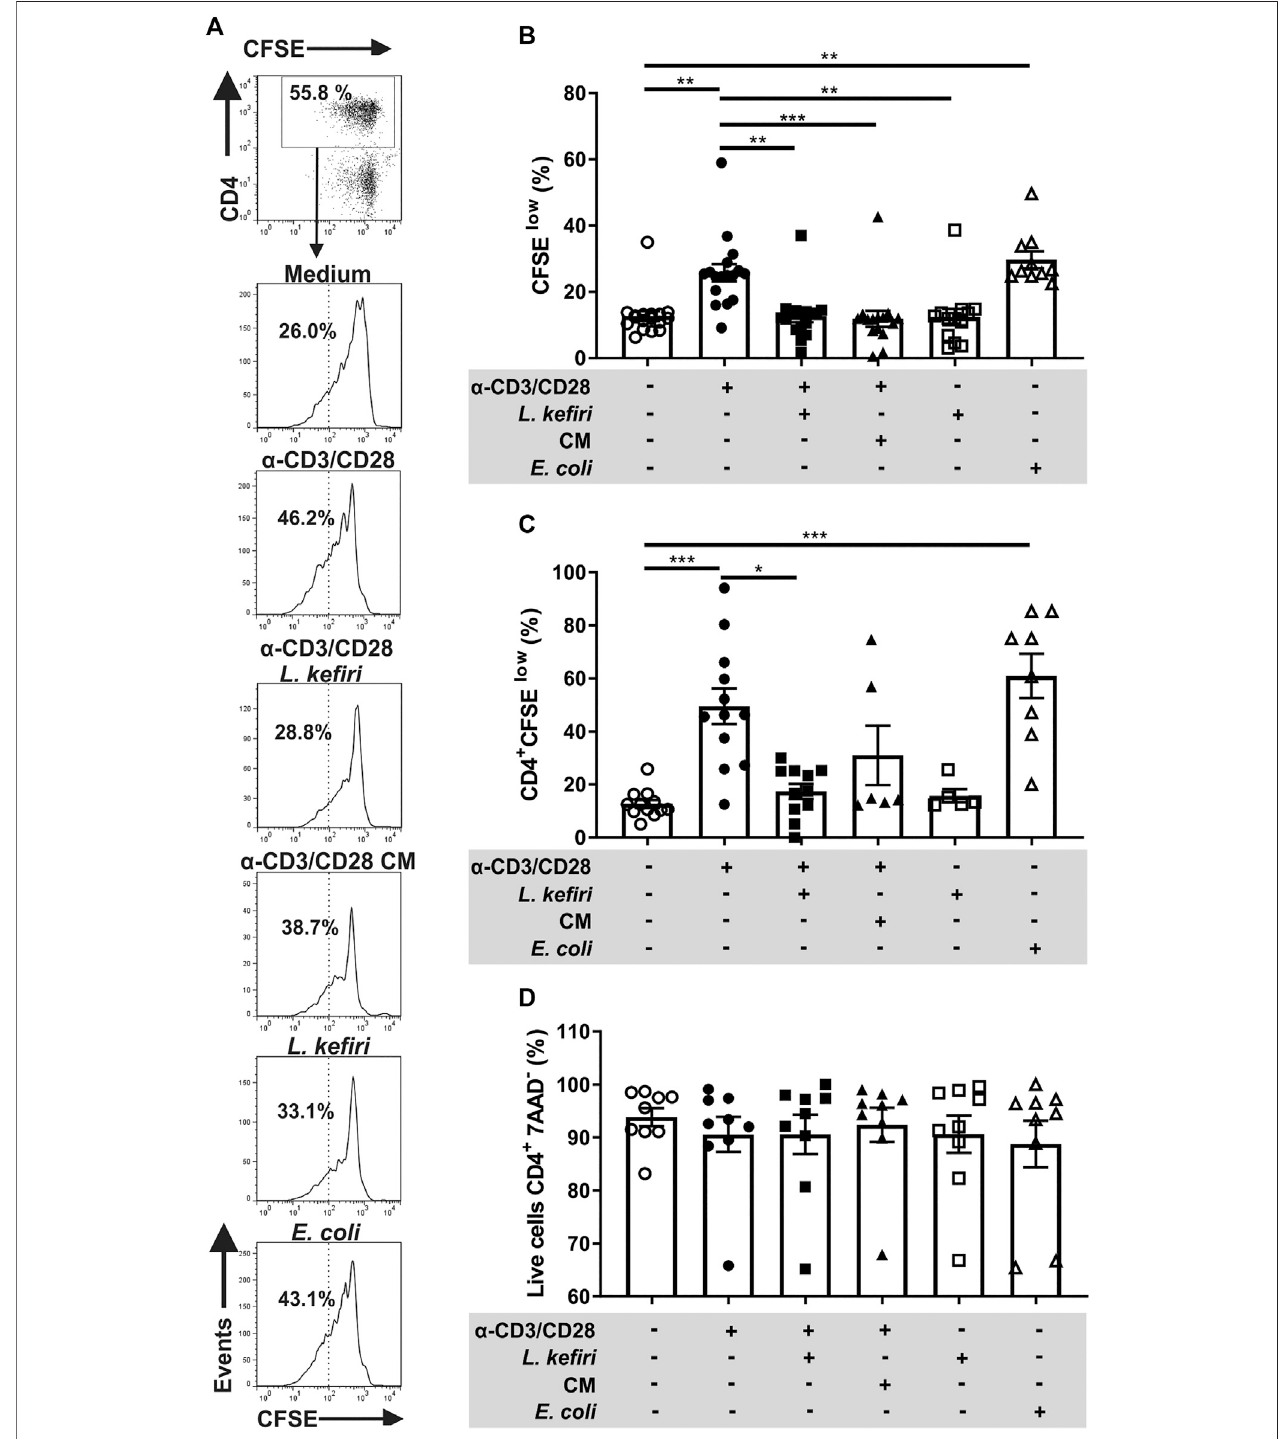
FIGURE 2 | Proliferation and LPTC response are impaired by L. ke fi ri (A). LPTC were activated with anti-CD3 and anti-CD28 and incubated with live probiotic, conditionedmedium(CM),EA E .coli ormedium.Cellproliferationwasassessedby fl owcytometrywithCFSE.Thegatingstrategyisshown:CD4 + cellsweregatedfrom the lymphocytegate on theforwardand sidescatter plot. Histograms for CFSEstainingare shown separately for each stimulus. Representative results from one patient are shown (B) . LPTC proliferation shown as percentage of “ CFSE low ” staining population under each stimulus in vitro. Each symbol represents one independent experiment (C) . Proliferation of CD4 + LPTC is shown as percentage of CFSE low cells obtained by the strategy shown in A, each symbol represents one independent experiment (D) . CD4 + LPTC cell death was assessed by fl ow cytometry with 7-AAD staining, in the same LPTC cultures. * p < 0.05, ** p < 0.01, *** p < 0.001.